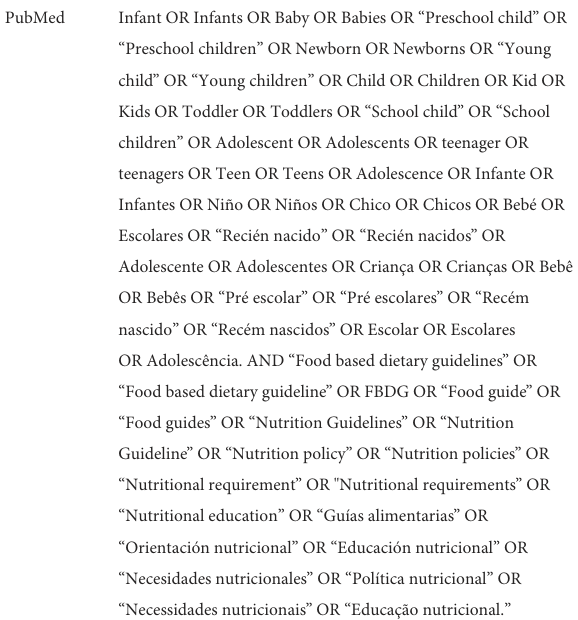
TABLE 1 Search strategy for PubMed